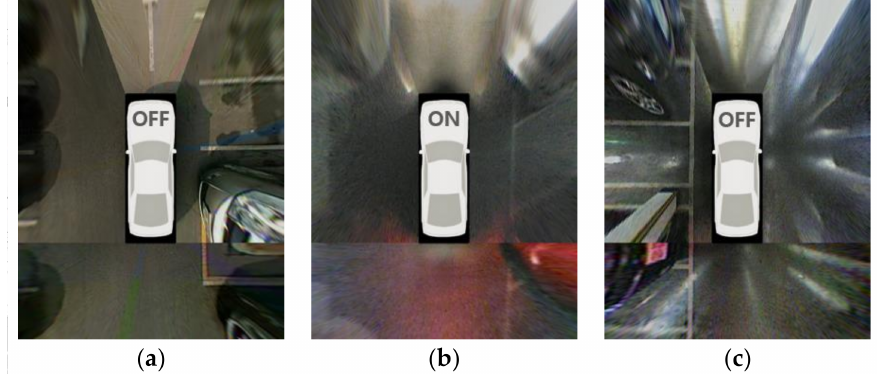
Figure 1. Parking lot images taken by an around-view monitoring (AVM) system. ( a ) Daytime; ( b ) Nighttime; ( c )